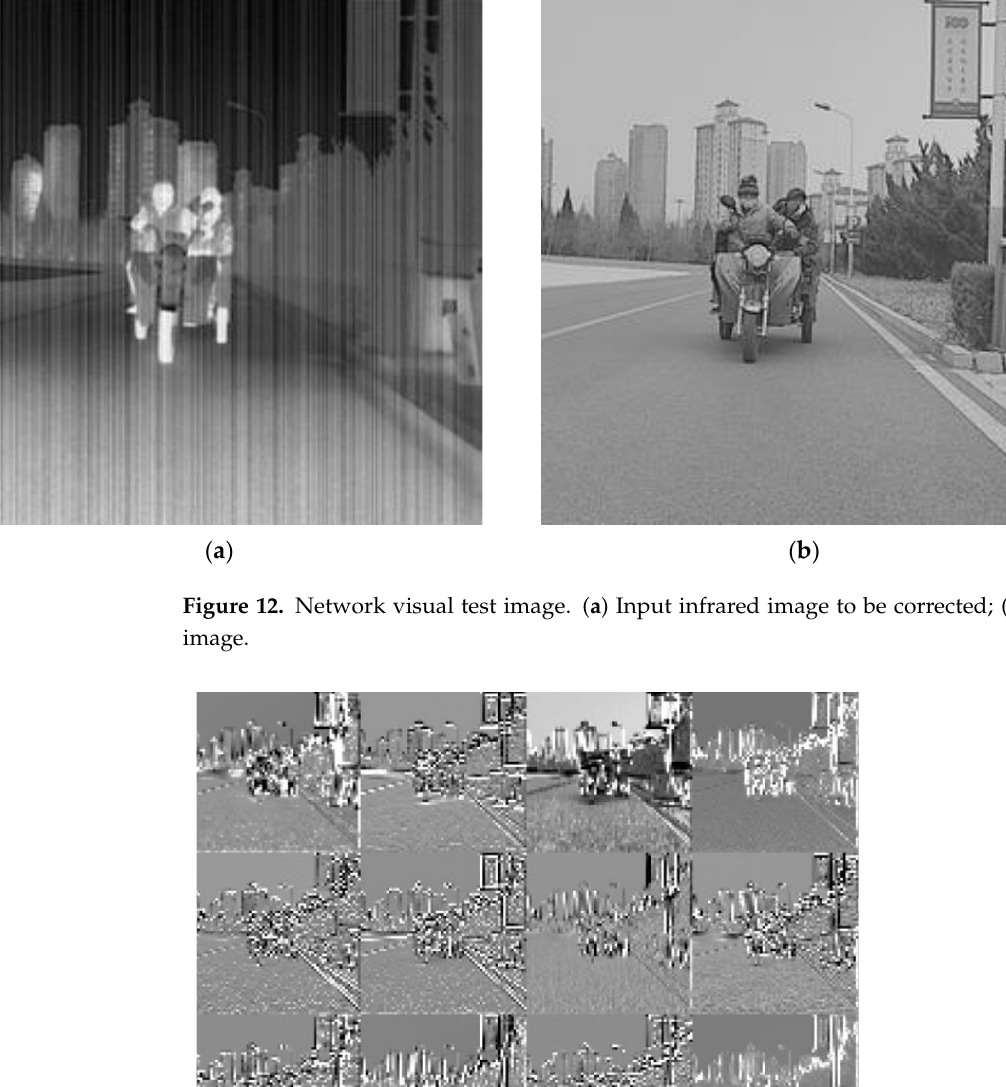
Figure 12. Network visual test image. ( a ) Input infrared image to be corrected; ( b ) input visible image.